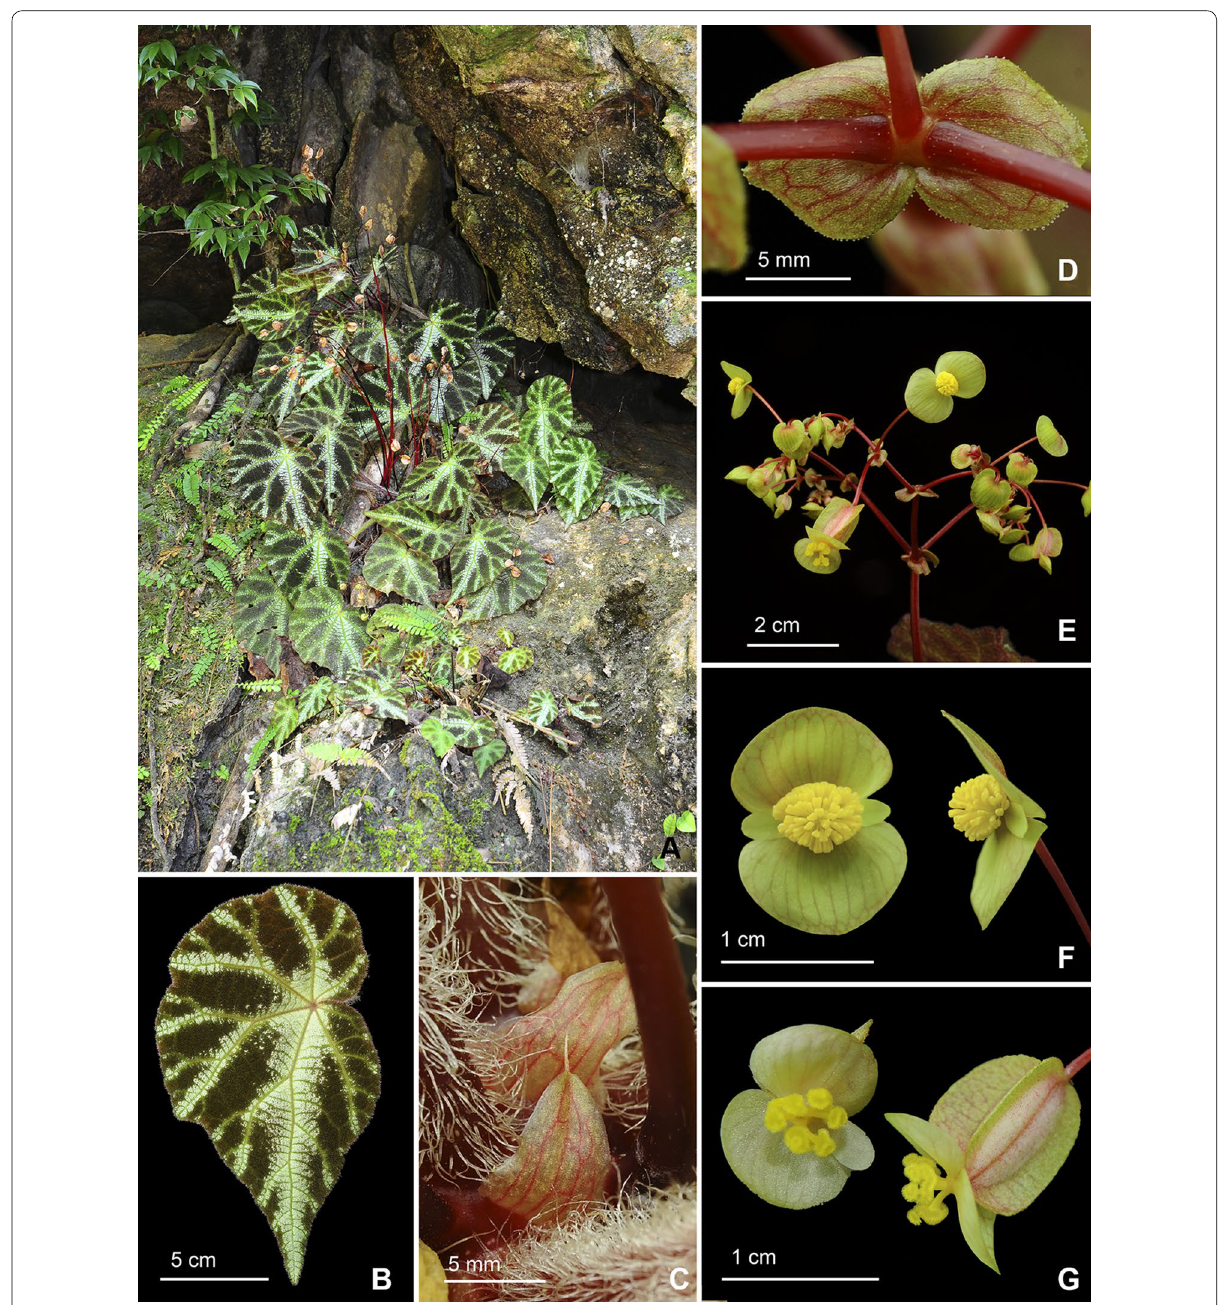
Fig. 6 Begonia larvata C.I Peng, Yan Liu & W.B.Xu. A Habitat and habit; B Leaf adaxial view; C Stipules; D Bracts; E Inflorescence, showing 2 tepals flowers; F Staminate flowers; G Pistillate flowers. All from Peng et al . 24372